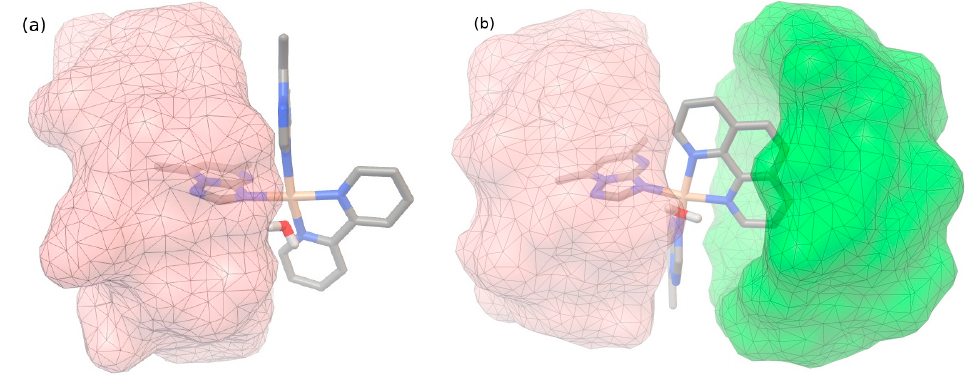
Figure 3. Putative docking result of ( 1a )@ β -CD ( a ), and ( 2a )@ β -CD ( b ) supramolecular association as simulated with AutoDock-Vina algorithm.